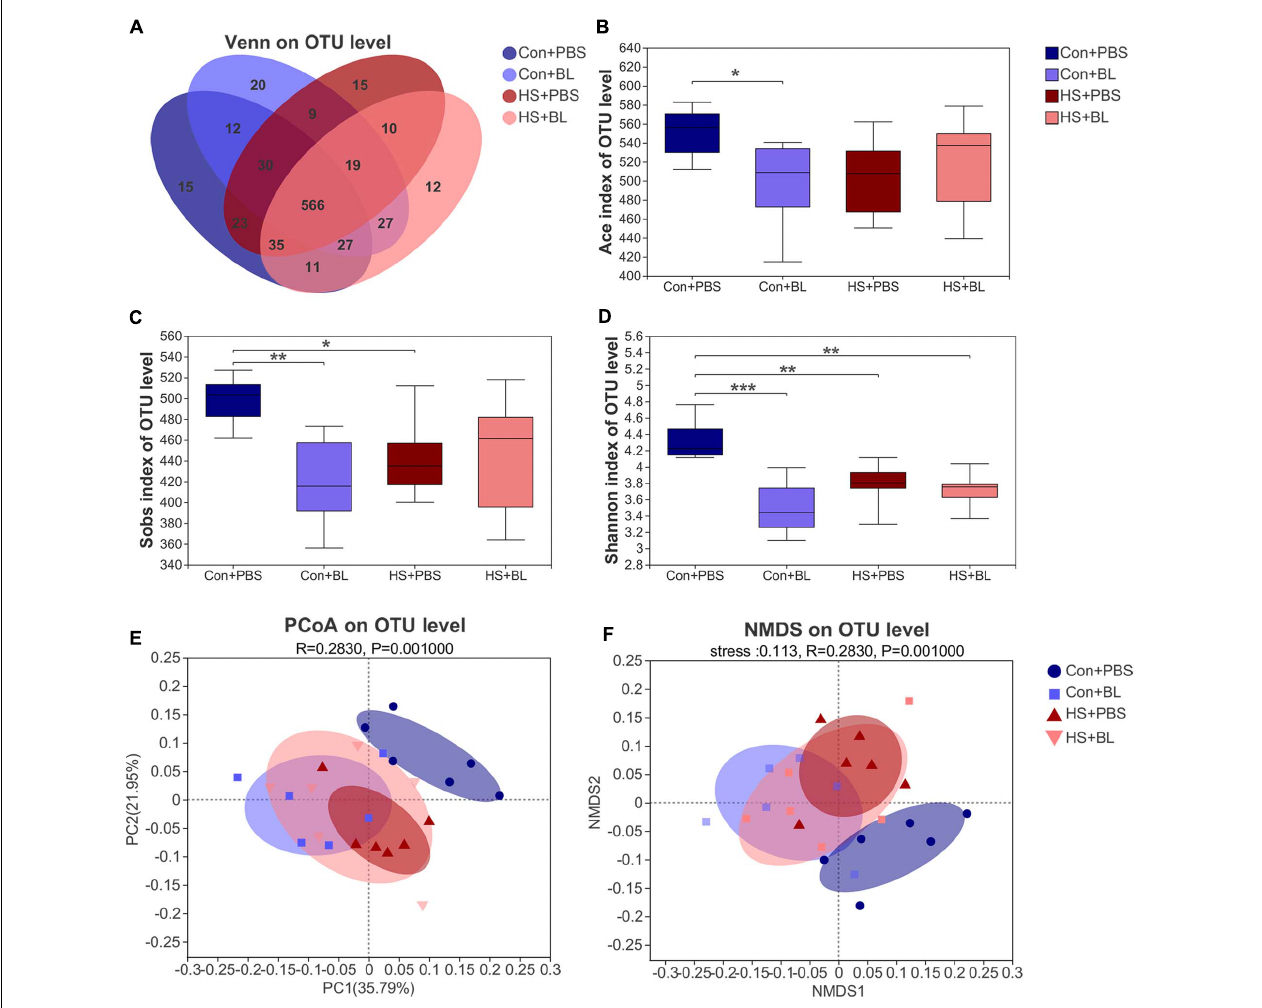
FIGURE 5 | BL pre-administration and HS induction modulated the overall structure of gut microbiota of rats according to analysis of α -diversity and β -diversity. (A) Venn diagram of the operational taxonomic unit (OTU) distribution shows unique and shared OTUs between different experimental groups ( n = 4). The Ace (B) , Sobs (C) , and Shannon (D) indexes of α -diversity analysis at the OTU level were calculated and compared among four groups. (E,F) β -Diversity was calculated by multivariate statistical analysis including principal coordinate analysis (PCoA), non-metric multidimensional scaling analysis (NMDS), and analysis of similarities (ANOSIM) at the OTU level based on weighted unifrac analysis, indicating significantly different gut microbiota structures among the four groups (ANOSIM, R = 0.283, P = 0.001). Data (B–D) are presented as a box-and-whisker plot of six rats per group. * P < 0.05, ** P < 0.01, *** P <